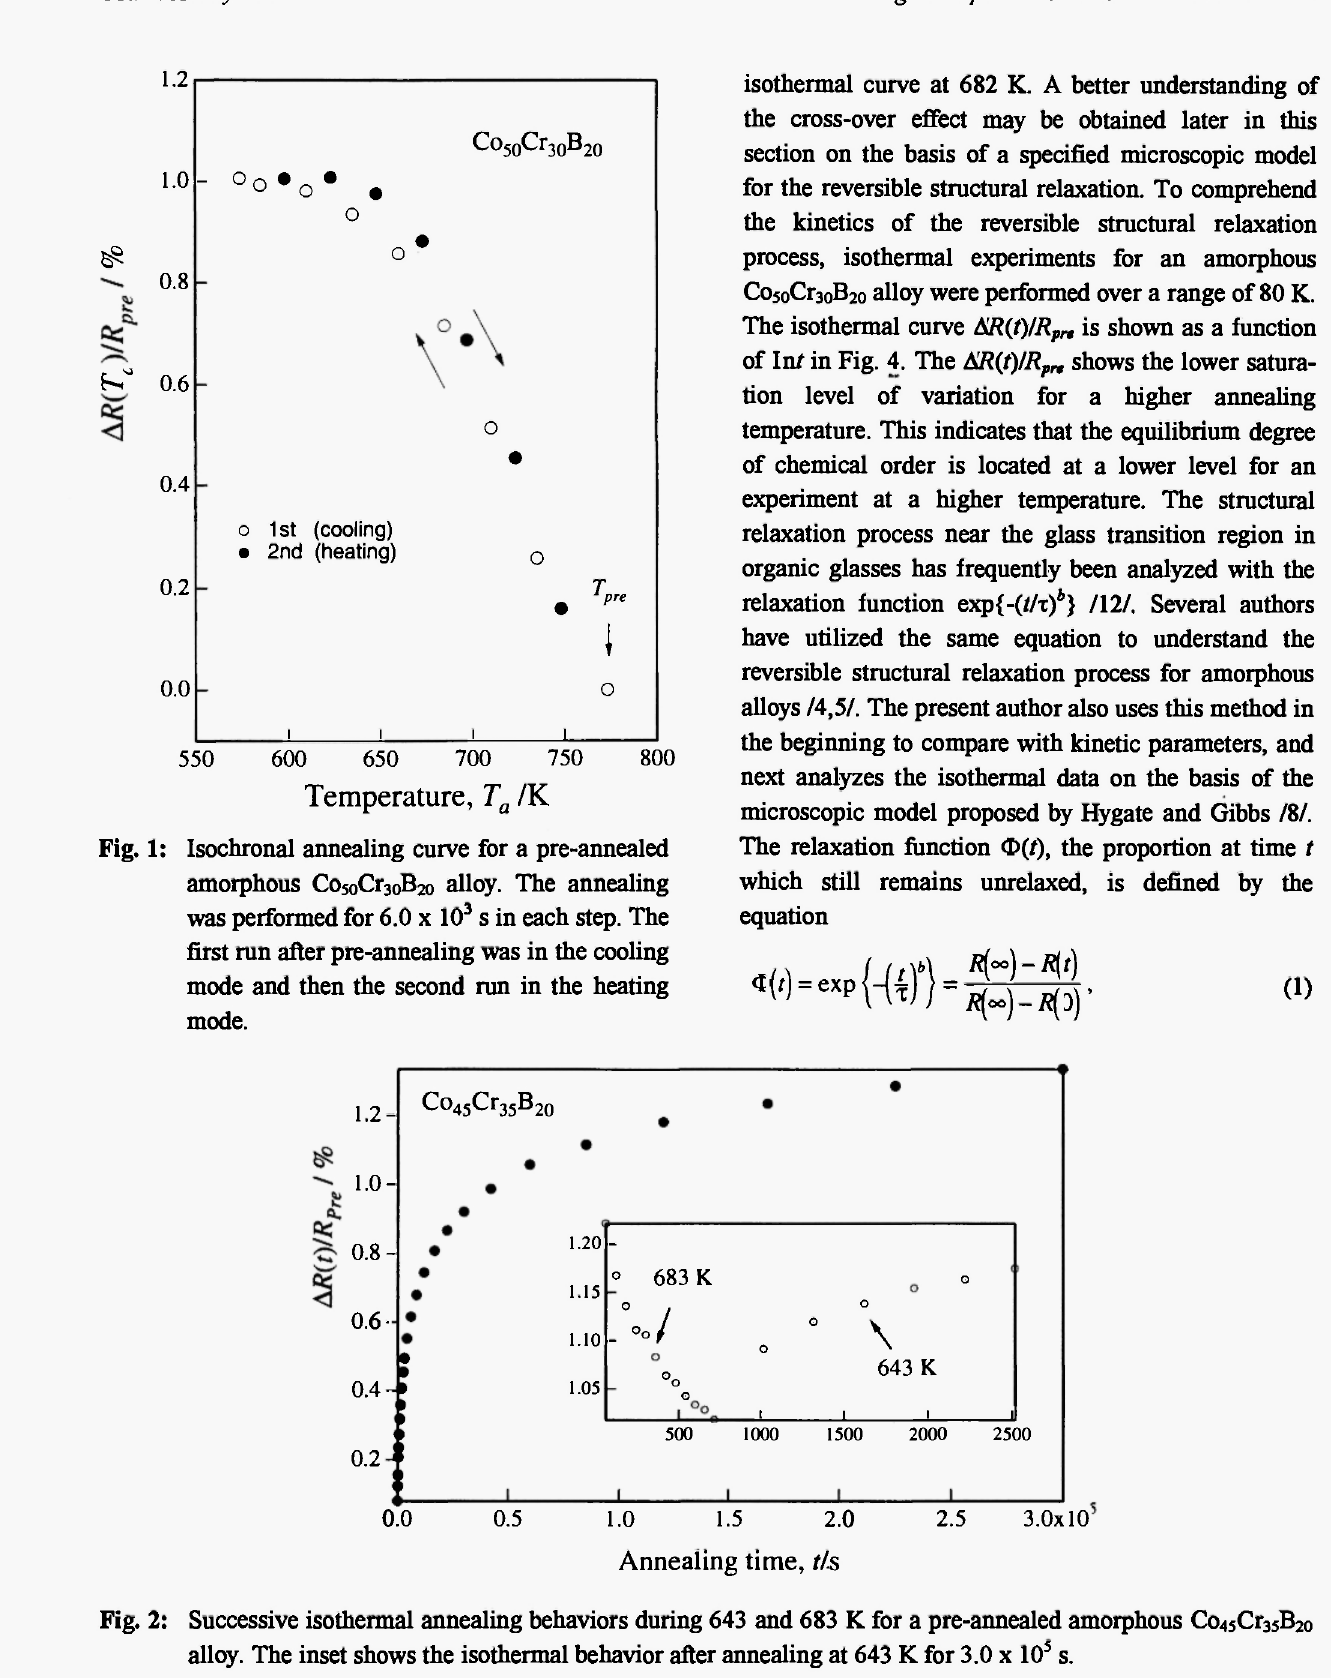
Fig. 2: Successive isothermal annealing behaviors during 643 and 683 Κ for a pre-annealed amorphous Co45Cr 3 5B 2 o alloy. The inset shows the isothermal behavior after annealing at 643 Κ for 3.0 χ 10 5